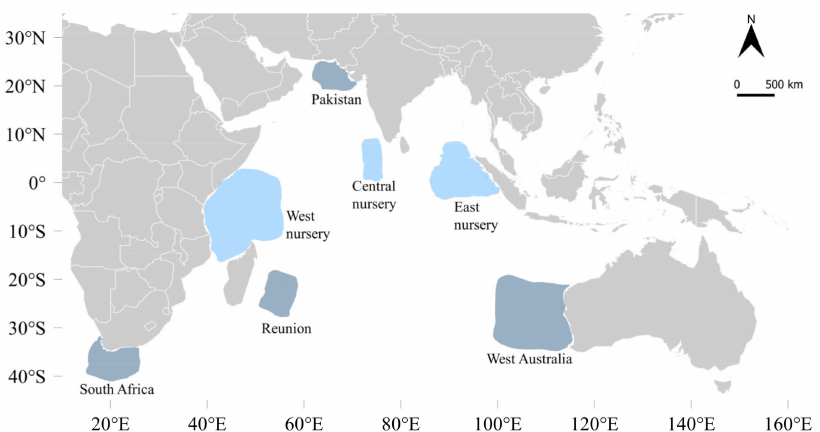
Figure 1. Sampling distribution of yellowfin tuna ( Thunnus albacares ) in the Indian Ocean. Otolith collections included young of the year from nursery areas used as baseline (light blue) and sub-adults and/or adults from fishery grounds (dark